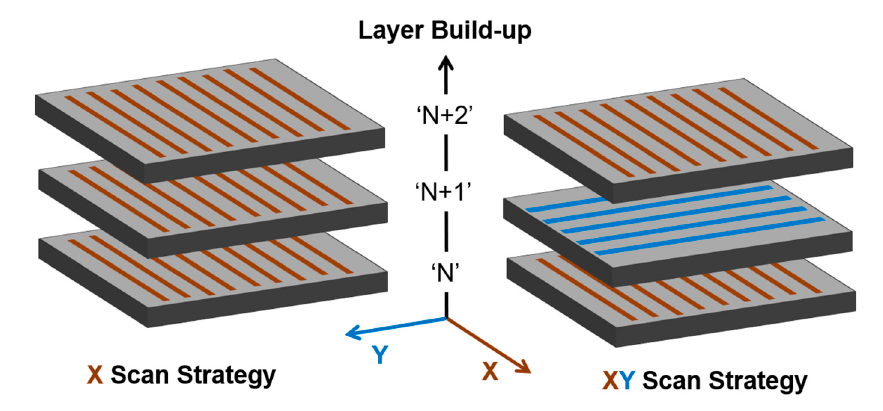
Figure 5. The bi-directional (X) and cross-directional (XY) scan strategies used by Becker et al. [39] and Bhardwaj et al. [38] to compare the residual stress state, texture, and mechanical properties in maraging steel 300. “ N ” represents an arbitrary build layer and subsequent layers are labelled “ N + 1” and “ N + 2”.